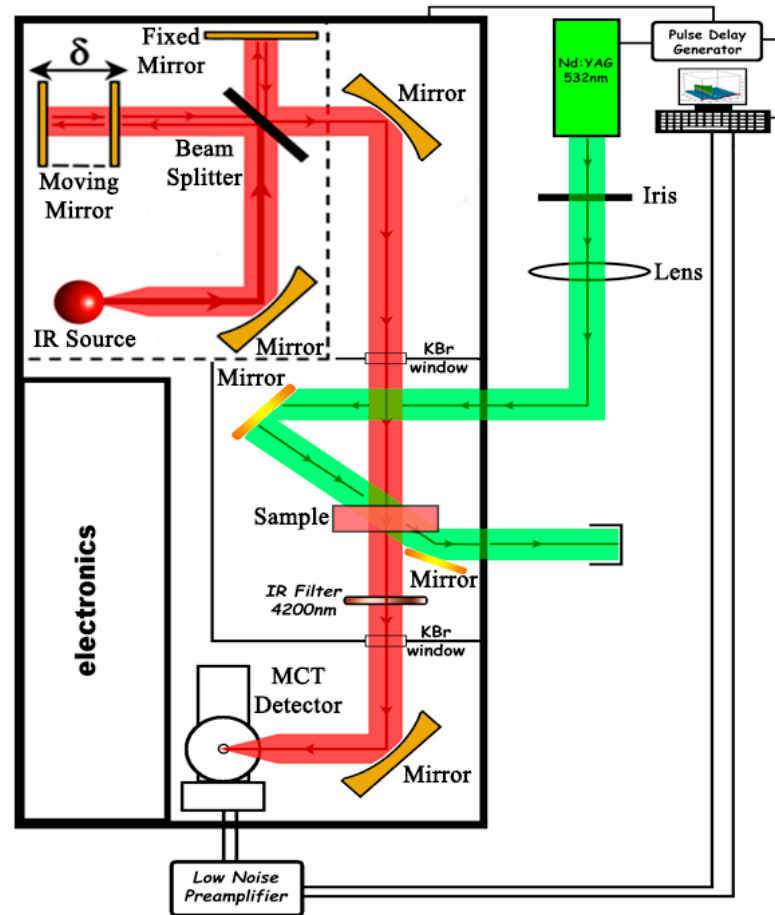
Figure 8. Experimental setup for the ns Time-Resolved Step-Scan Fourier Transform Infrared (ns TRS 2 − FTIR). The red and green arrows represent the infrared beam and the 532 nm photolysis beam, respectively.